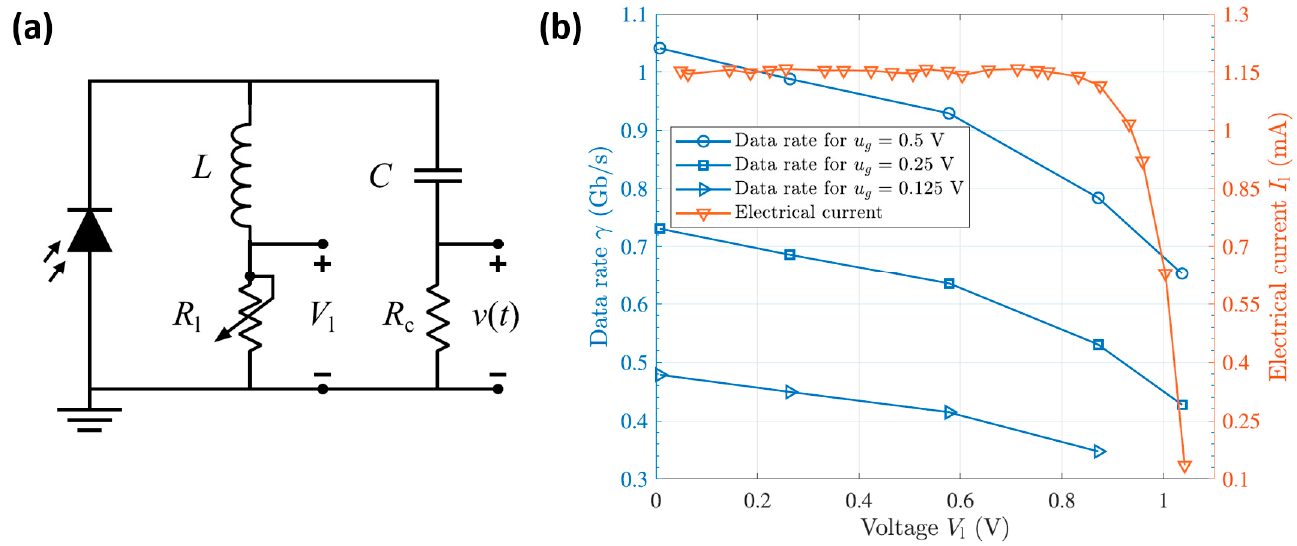
Figure 5. ( a ) Electrical circuit of the GaAs PV-based receiver used in reference [84]. ( b ) Corresponding data rate and DC current as a function of load voltage for an OFDM-based transmission with adaptative bit and power loading. Reproduced with permission from reference [84].